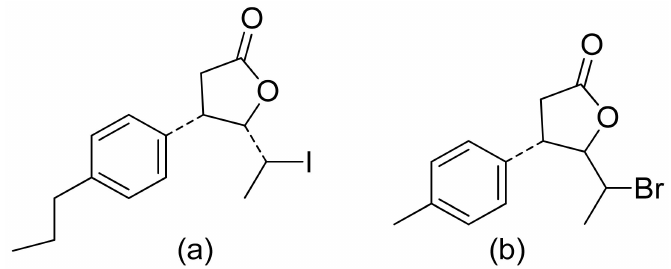
Figure 11. Iodo- ( a ) and bromolactone ( b ) from simple aromatic aldehydes. The Lage group evaluated the antitumor activity of lactones against multidrug- resistant cell cancer lines: EPG85-257P (parental, drug-sensitive gastric carcinoma), EPG85- 257RDB (gastric carcinoma with the classical MDR phenotype), EPG85-257RNOV (gastric carcinoma with an atypical MDR phenotype), EPP85-181P (parental, drug-sensitive pan- creatic carcinoma), EPP85-181RDB (pancreatic carcinoma with the classical MDR pheno- type), EPP85-181RNOV (pancreatic carcinoma with an atypical MDR phenotype), HT29P (parental, drug-sensitive colon carcinoma), HT-29RDB (colon carcinoma with the